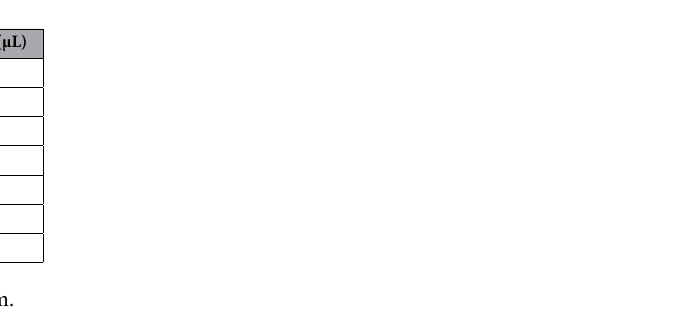
Table 3. qRT-PCR reaction